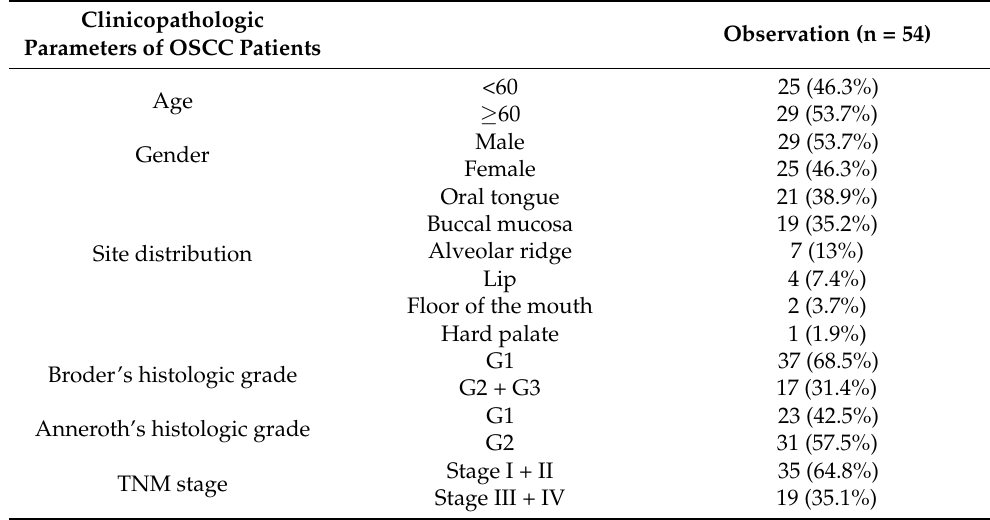
Table 3. Clinicopathologic parameters of OSCC